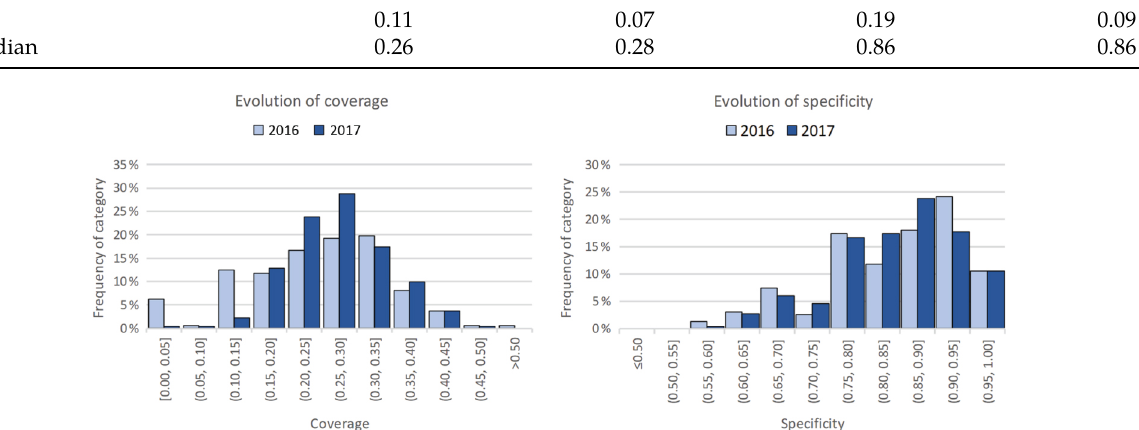
Figure 3: The evolution in the distribution of the two measurements of metadata quality in MetaboLights. On the left, the distributions for term coverage; on the right, the distribution for semantic specificity. The light blue represents data from the 2016 dataset and the dark blue from the 2017